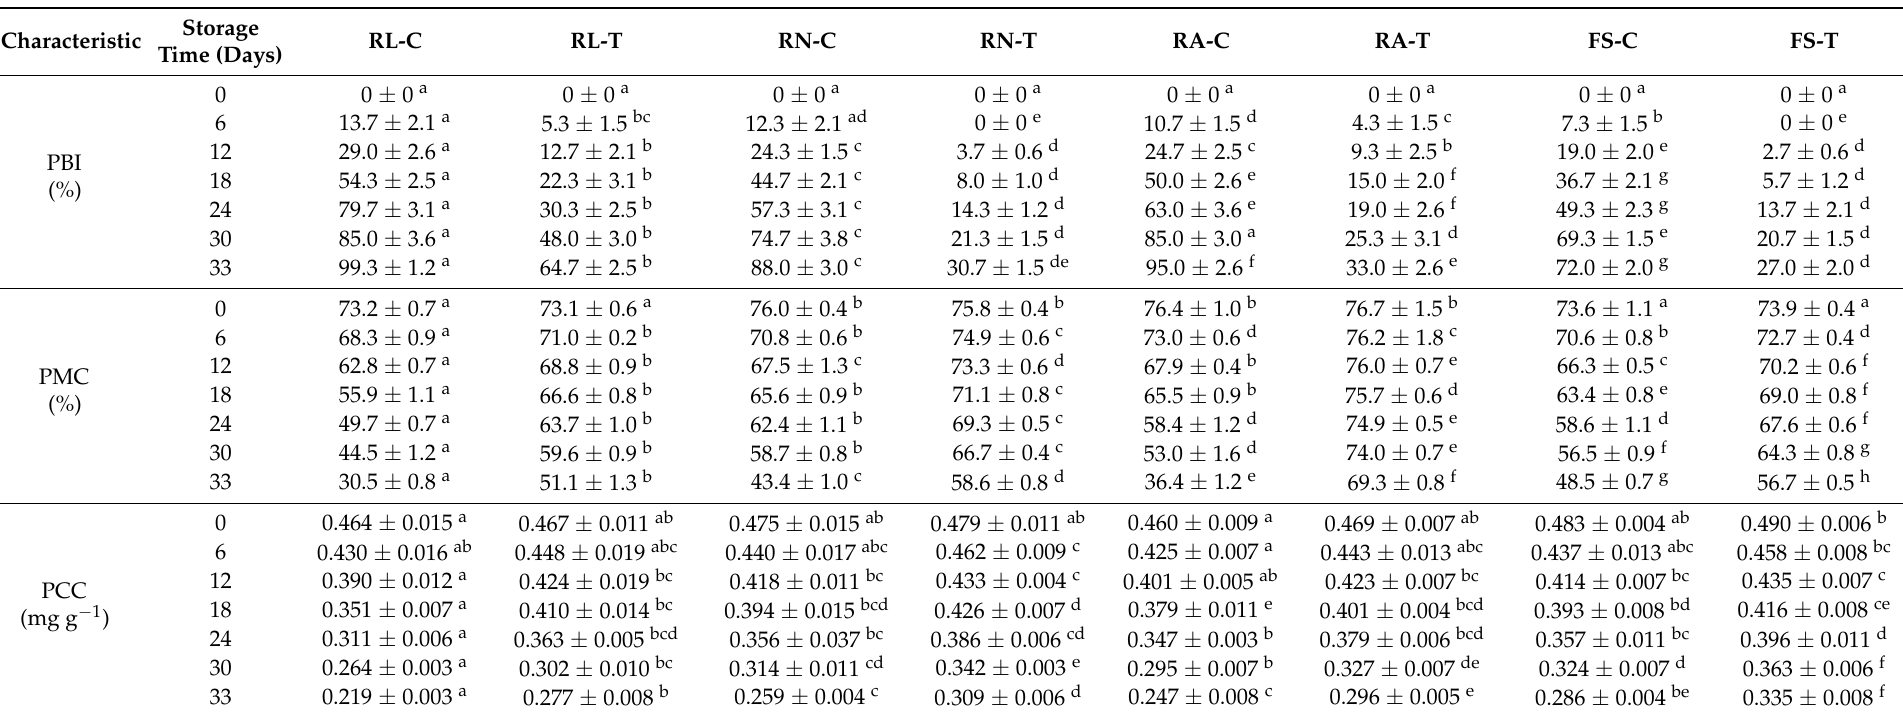
Table 5. Mean values for the peduncle freshness parameters: Peduncle Browning Incidence (PBI), Peduncle Moisture Content (PMC), and Peduncle Chlorophyll Content (PCC) at harvest (0) and after 6, 12, 18, 24, 30, and 33 days storage for control and AA-CaCl 2 -CMCS-GL coated fruit.